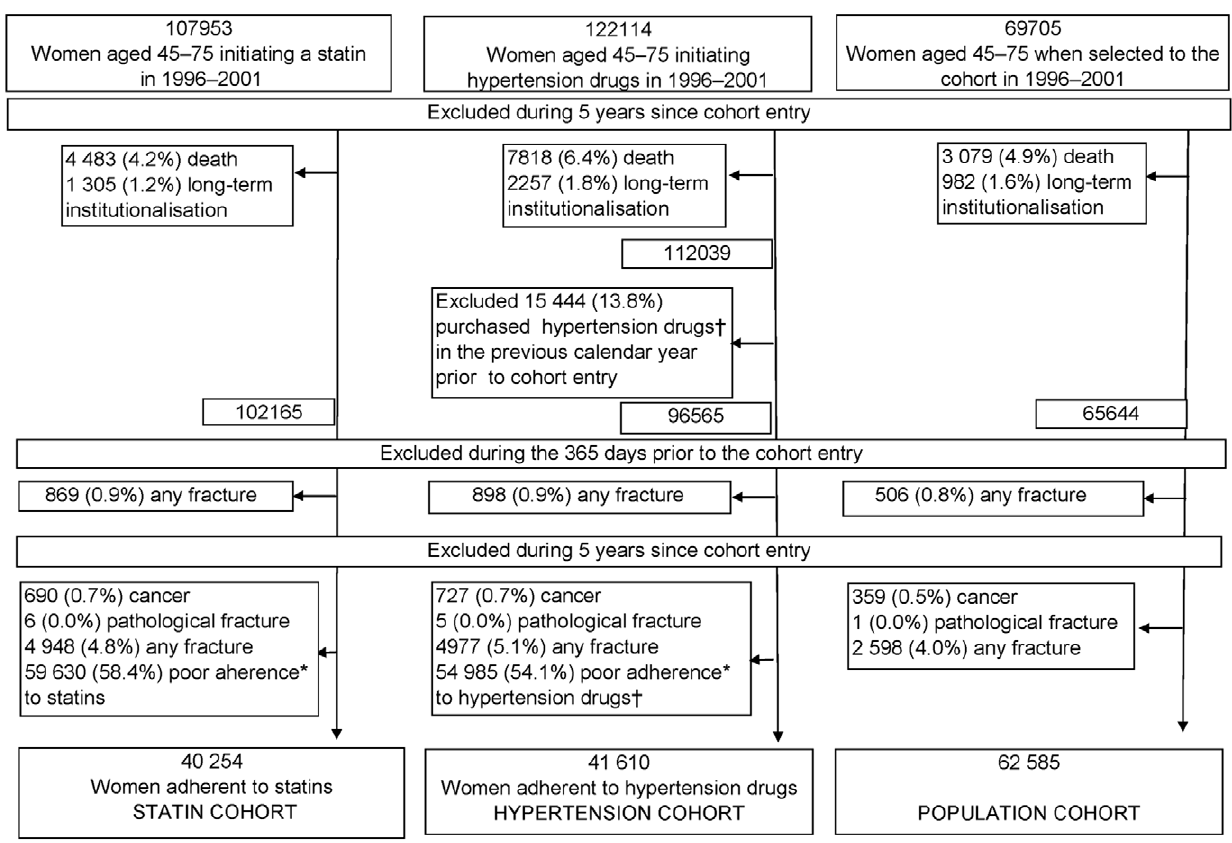
Figure 1. Flow diagram of the study cohorts. *Poor adherence=prescribed days covered , 80% in the 5-year exposure period and no more than 2 purchased statin/hypertension drug prescription in each year. { Hypertension drugs=beta blockers, angiotensin-converting enzyme inhibitors or angiotensin receptor blockers, calcium channel blockers.